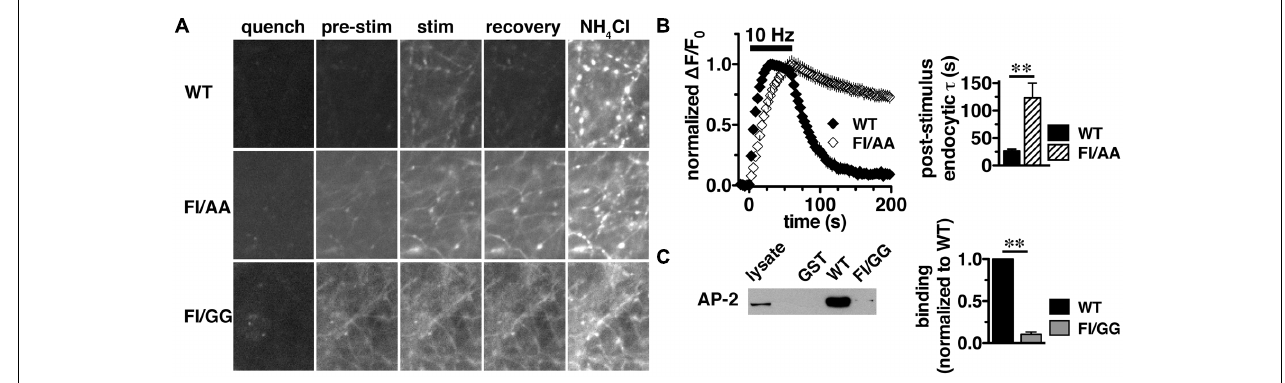
FIGURE 5 | A C-terminal dileucine-like motif is essential for VGLUT2 synaptic targeting and recycling. (A) Representative images of neurons expressing WT, FI/AA or FI/GG VGLUT2-pH in Tyrode’s buffered with MES pH 5.5 to quench surface fluorescence (quench); at rest, pH 7.4 (pre-stimulus); during 10 Hz 60 s stimulation, near peak fluorescence (stim); during recovery after termination of the stimulus (recovery); and upon alkalinization in 50 mM NH 4 Cl to visualize total pHluorin levels. The fluorescence of WT VGLUT2-pH increases upon stimulation and quickly recovers to baseline after stimulation stops (top panels). Mutation of the F 518 I 519 residues to either alanine (FI/AA) or glycine (FI/GG) results in more protein stranded at the cell surface (middle and bottom panels). A fraction of FI/AA in puncta responds to action potential stimulation with an increase in fluorescence, but fails to recover (middle panels). FI/GG mutation severely disrupts synaptic targeting, with fluorescence diffused along neuronal processes, with virtually no response to electrical stimulation (bottom panel). Scale bar, 10 µ m. (B) Left panel: Time course of changes in fluorescence intensity of neurons expressing either WT or FI/AA VGLUT2-pH, normalized to peak. Upon stimulation, WT exhibits a rapid increase in fluorescence consistent with exocytosis, followed by rapid recovery to baseline after the termination of stimulation (black). The small fraction of FI/AA that appears punctate responds to stimulation but fails to recover (open symbols). Right panel: The post-stimulus endocytic rate of FI/AA is dramatically slower than that of WT (WT, τ = 26.76 ± 2.963 s, n = 6; FI/AA, τ = 123.2 ± 26.81 s, n = 7, ∗∗ p < 0.01). Data in (B) are means ± SEM of (cid:49) F/F 0 , acquired every 3 s, normalized to total fluorescence and to the peak fluorescence in each trace during stimulation. Data are from at least 41 synapses per coverslip from 6 to 8 coverslips from at least two independent cultures. (C) VGLUT2 interacts with the clathrin adaptor protein adaptor protein (AP)-2 through its dileucine-like motif. A GST fusion of the WT VGLUT2 C-terminus specifically pulls down AP-2 from the rat brain lysates, but mutation of F 518 I 519 to GG disrupts the interaction. Left panel: A representative immunoblot of bound proteins detected by antibody to AP-2. Right panel: The averaged quantified band intensity from three independent experiments, ∗∗ p <